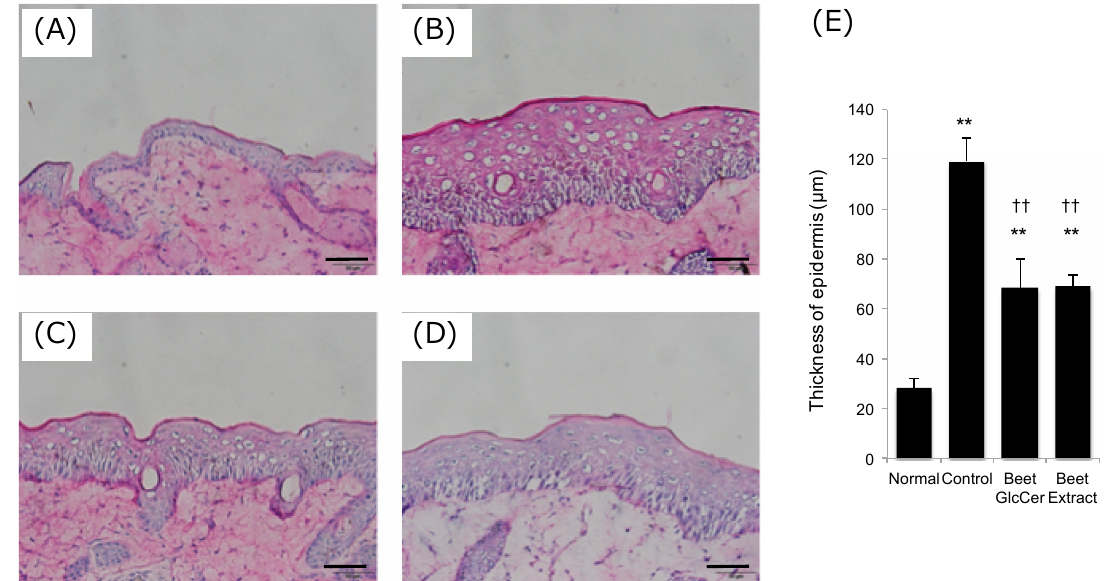
Figure 2. Hematoxylin and eosin staining, and thickness of epidermis in mouse skin. ( A ) Normal (without UVB irradiation, vehicle administration); ( B ) Control (200 mJ/cm 2 UVB irradiation, vehicle administration); ( C ) Beet GlcCer (200 mJ/cm 2 UVB irradiation, beet GlcCer oral administration); ( D ) Beet extract (200 mJ/cm 2 UVB irradiation, beet extract oral administration); and ( E ) Epidermal thickness in UVB irradiated mice ( n = 3). Scale bar indicates 50 µ m. ** p < 0.01 vs. normal group, †† p < 0.01 vs. control group, Tukey’s post-hoc multiple comparison test.